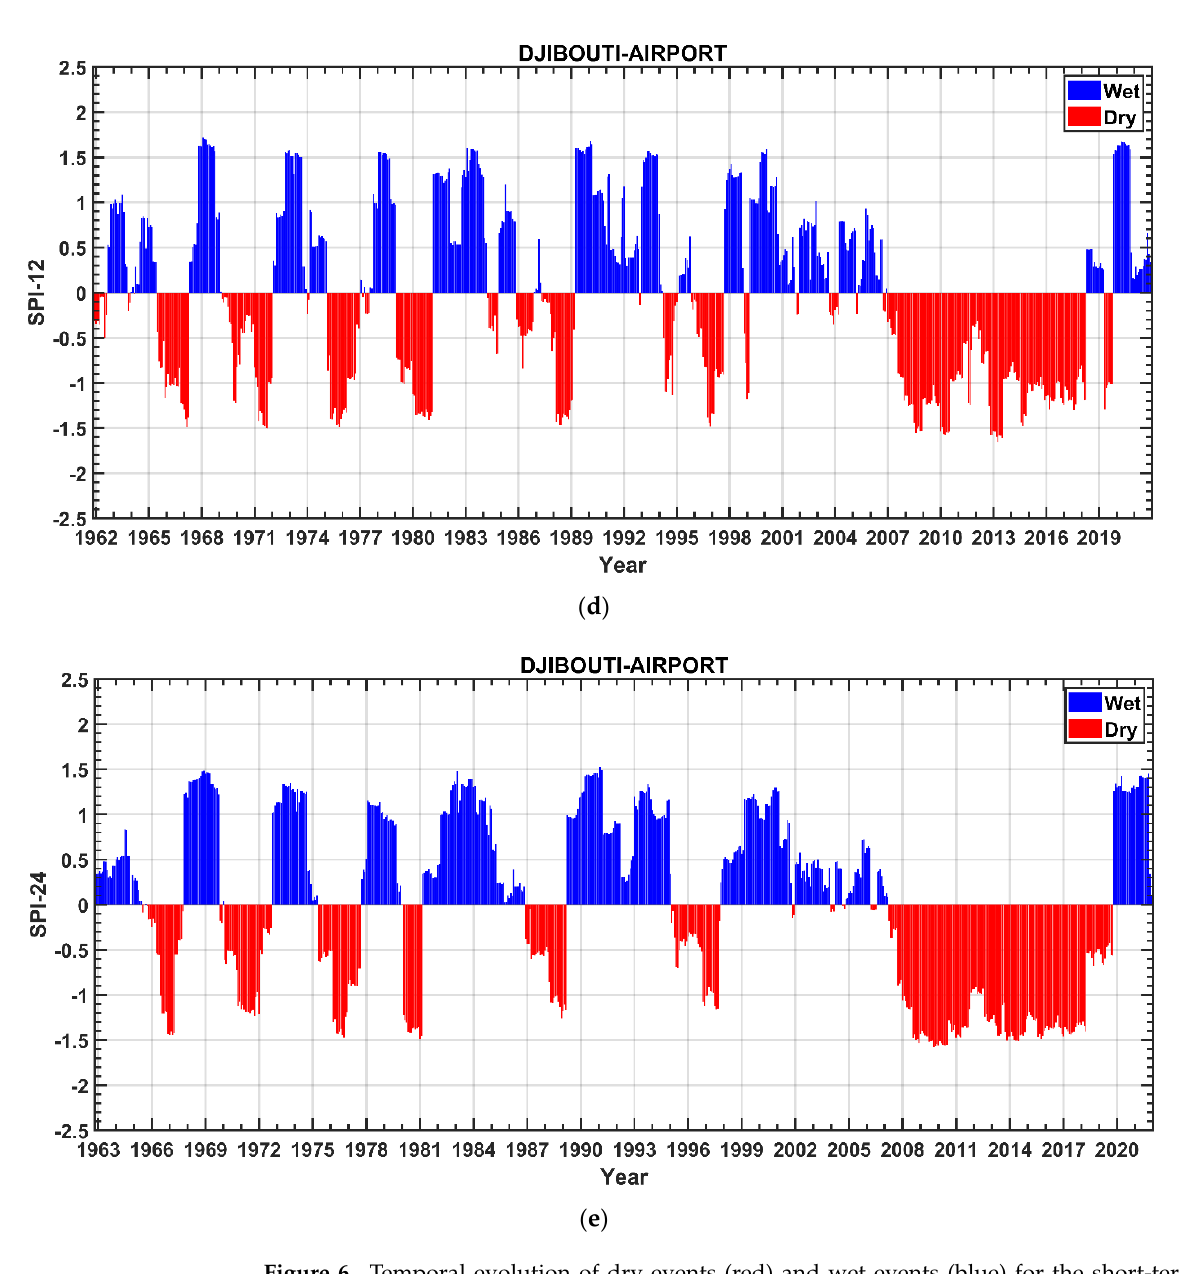
Figure 6. Temporal evolution of dry events (red) and wet events (blue) for the short-term and long-term SPI during the period 1961–2021: ( a ) SPI-3, ( b ) SPI-6, ( c ) SPI-9, ( d ) SPI-12, and ( e ) SPI-24. Drought duration, intensity, and frequency are important properties for the characterization of droughts. Table 3 presents the mean duration, frequency, and intensity of dry and wet events at various timescales over the Djibouti Airport station during 1961–2021 for both the SPI and SPEI. The duration of dry and wet events tended to increase with the SPI and SPEI timescales. The average drought durations were 2.77 and 6.93 months for SPI-3 and SPI-12, respectively, and 2.40 and 5.63 months for SPEI-3 and SPEI-12, respectively. The SPI revealed a higher frequency of dry events than the SPEI (for instance, 26.01% and 20.59% for SPI-24 and SPEI-24, respectively; Table 3). The average drought intensity varied from − 1.60 for SPI-3 to − 1.28 for SPI-12. This suggests that drought intensity decreases with the timescale.